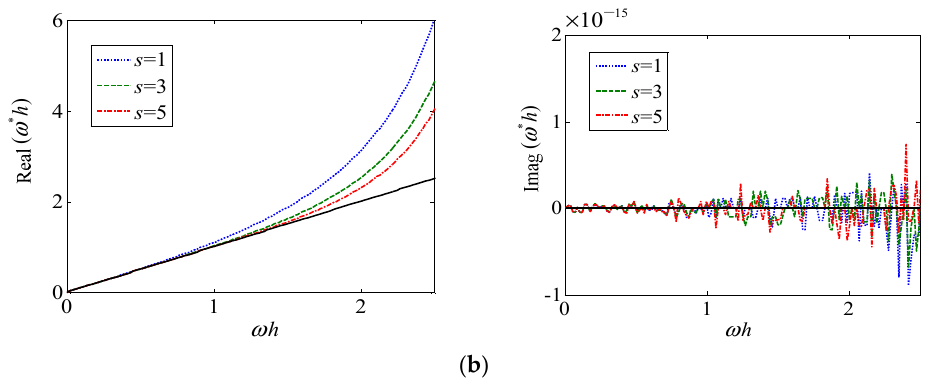
Figure 5. ( a ) Plot of real and imaginary parts of the modified wavenumber for GAMs with even s ; ( b ) plot of real and imaginary parts of the modified wavenumber for GAMs with odd s .